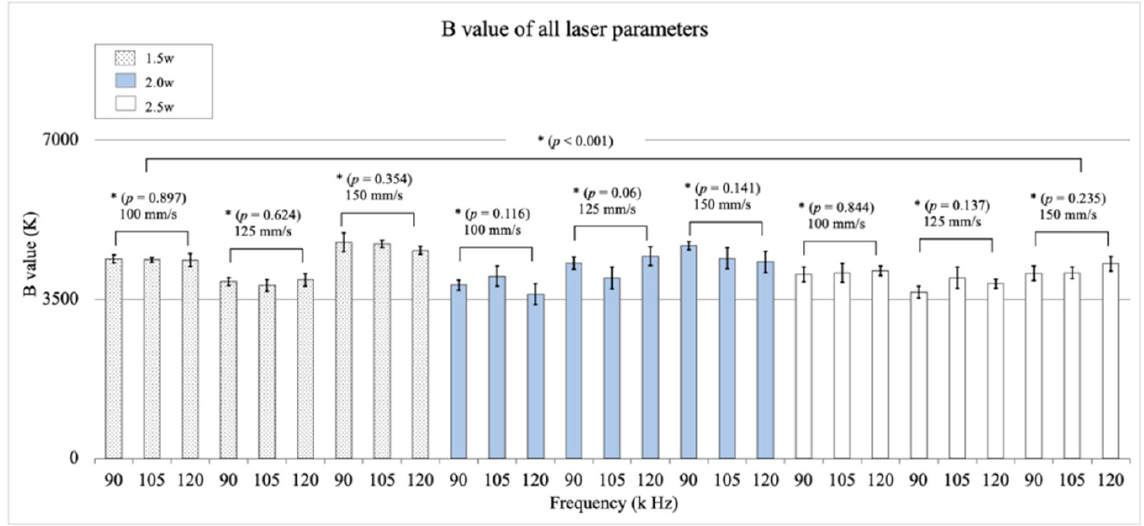
Figure 8. Sensitivity of all laser parameters.